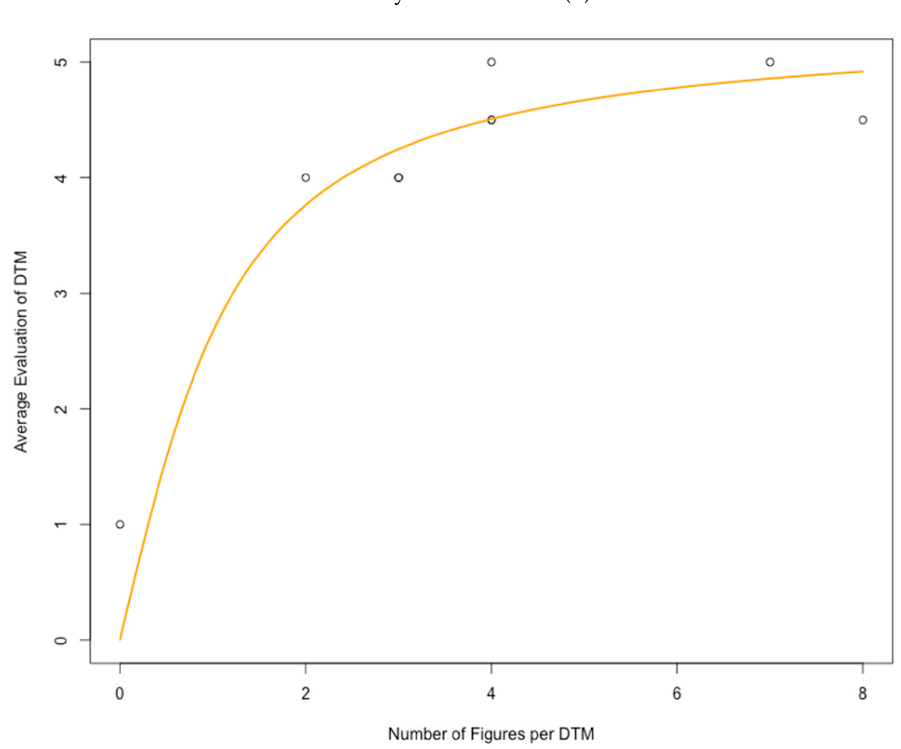
Figure 1. Number of figures per digital teaching module (DTM) and average evaluation (0: worst value; 5: best value) of the respective module.